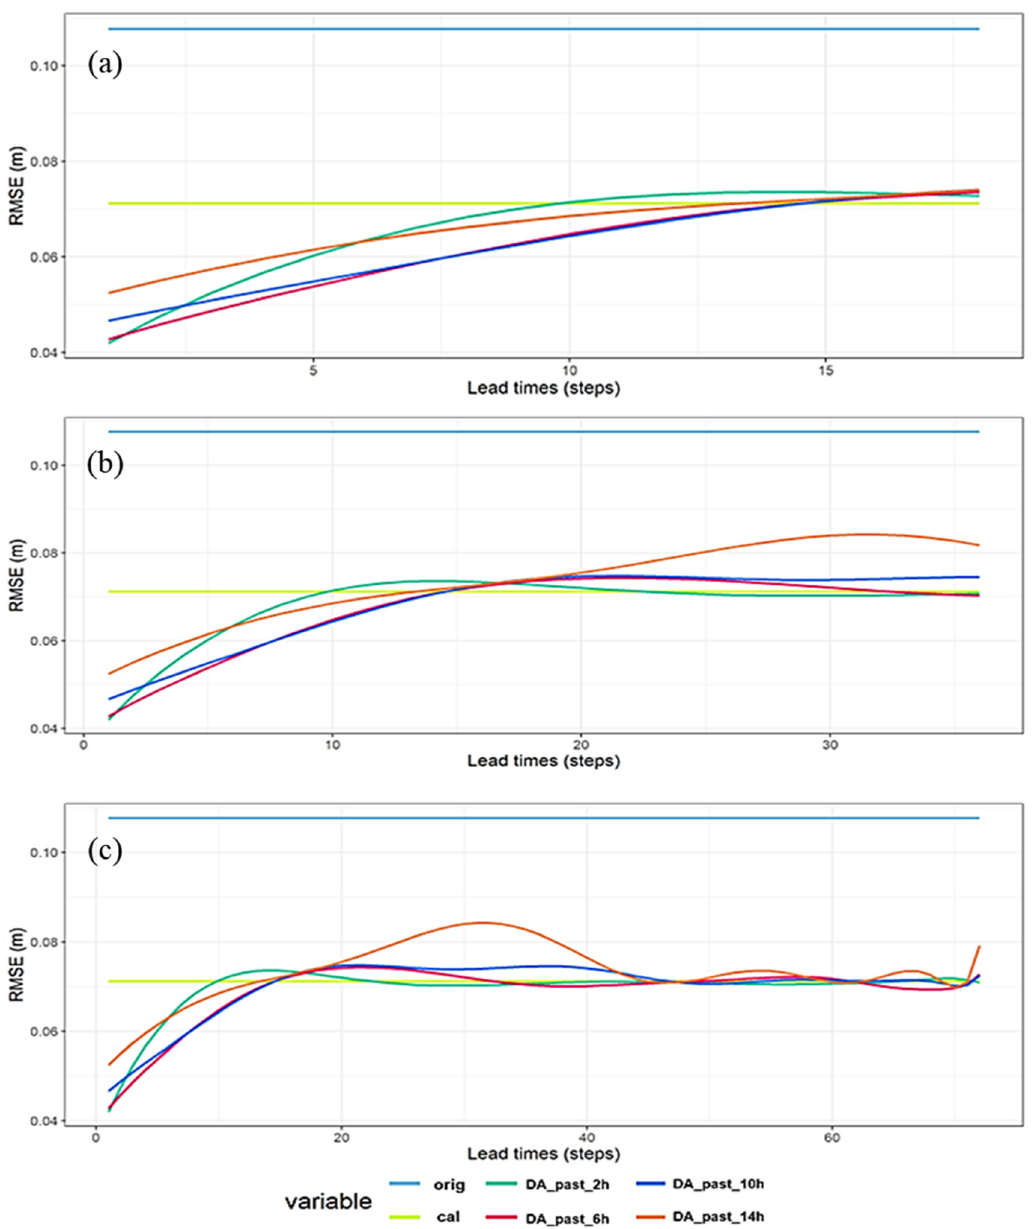
Figure 11. Performance of tidal wave prediction with varying DA lead times: ( a ) up to 3 h lead time; ( b ) up to 6 h lead time; ( c ) up to 12 h lead time.